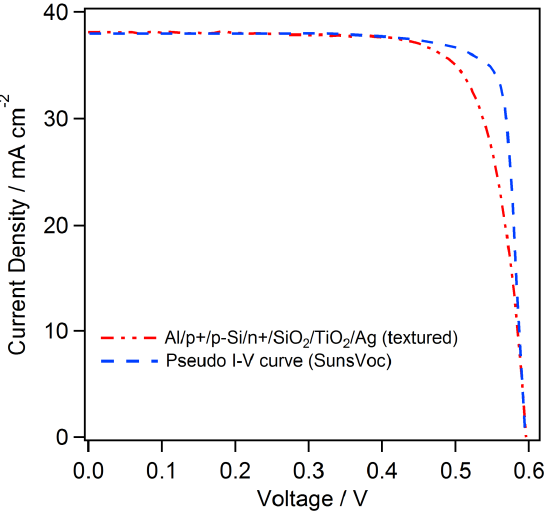
Figure 3. Measured I–V curve of the best cell compared with the pseudo I–V curve measured by Suns ‐ Voc.